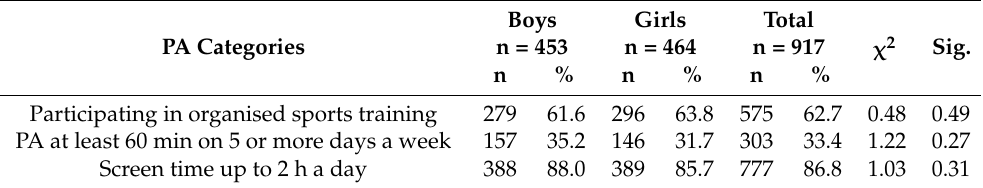
Table 3. Descriptive statistics of the respondents’ physical activity (PA). Statistical significance was calculated by using Chi-square analysis.